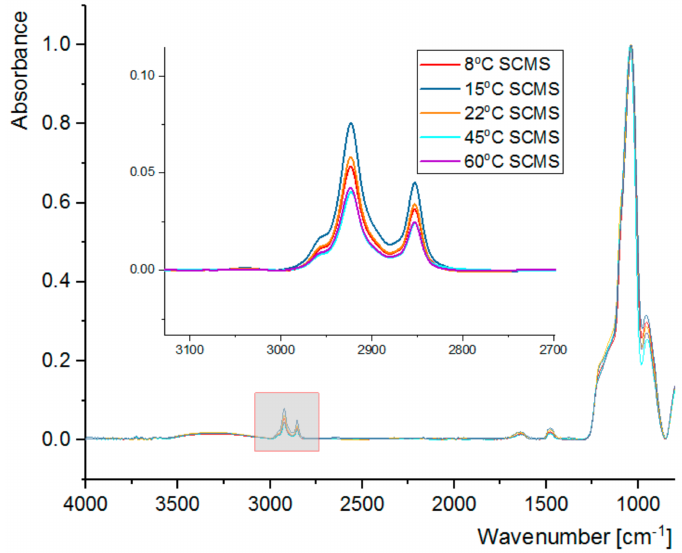
Figure 4. FT-IR spectra for SCMS particles synthesized at various